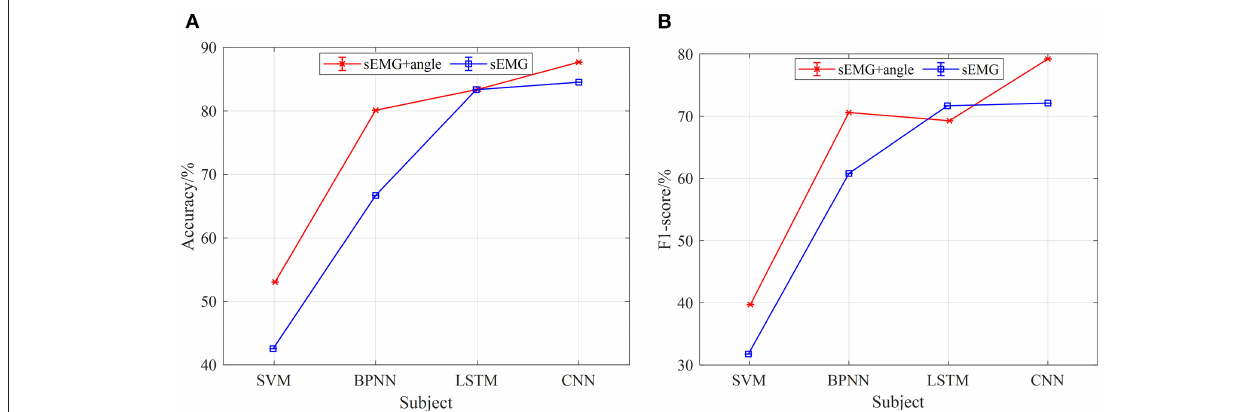
FIGURE 15 | The comparison results of different models of multi-information and single information input with the 5-fold cross-validation method at 3km/h, (A) comparison results of four model accuracy with different input information, (B) comparison results of four models F1-score with different input information.